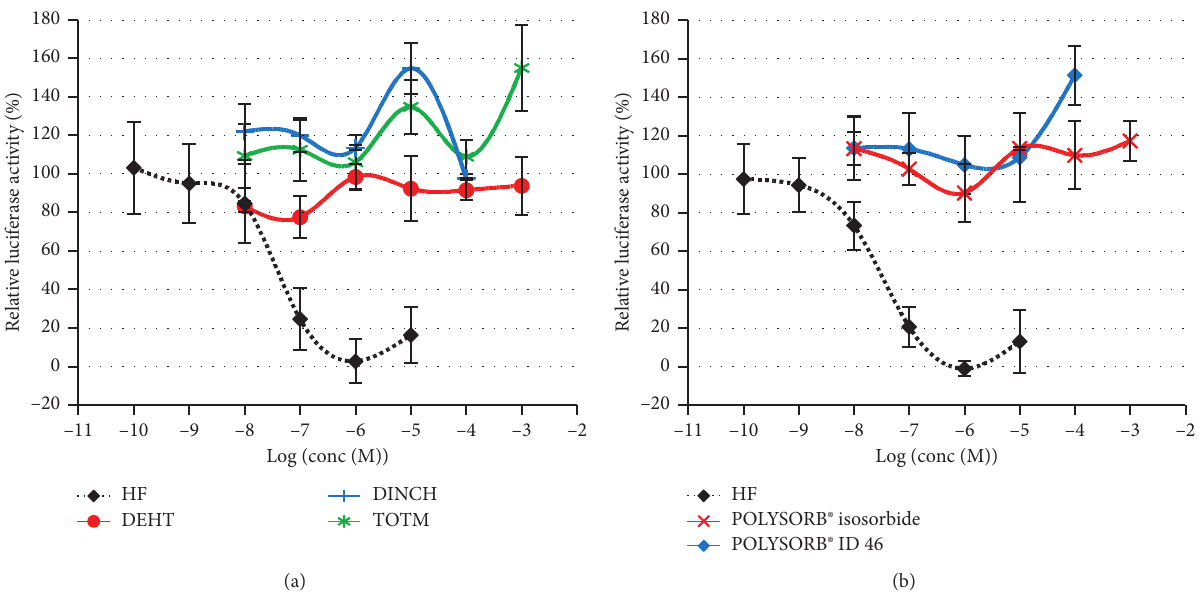
Figure 7: Antiandrogenic activity of phthalate substitutes in MDA-kb2 cells. MDA-kb2 cells were exposed for 20–24h to different concentrations of (a) DEHT, DINCH, or TOTM or (b) POLYSORB ® isosorbide or POLYSORB ® ID 46 or the reference antiandrogen hydroxyflutamide (HF) together with 0.25nM DHT. Results represent the mean relative luciferase activity compared to the solvent control with 0.25nM DHT ( � 100%) ± SD of 3 replicates from one representative assay out of 2